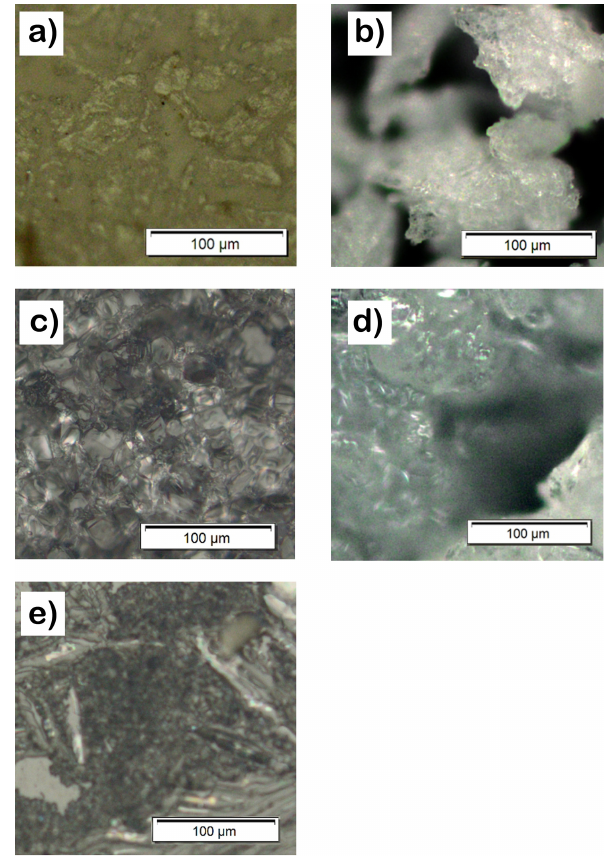
Figure 1. Optical microscopy images of the cellulose tablet, CT sample (a) ; dispersed cellulose, CDW sample (b) ; NaNO 2 pow- der (c) ; and a composite Cell + NaNO 2 sample taken in two dif- ferent areas (d, e) .